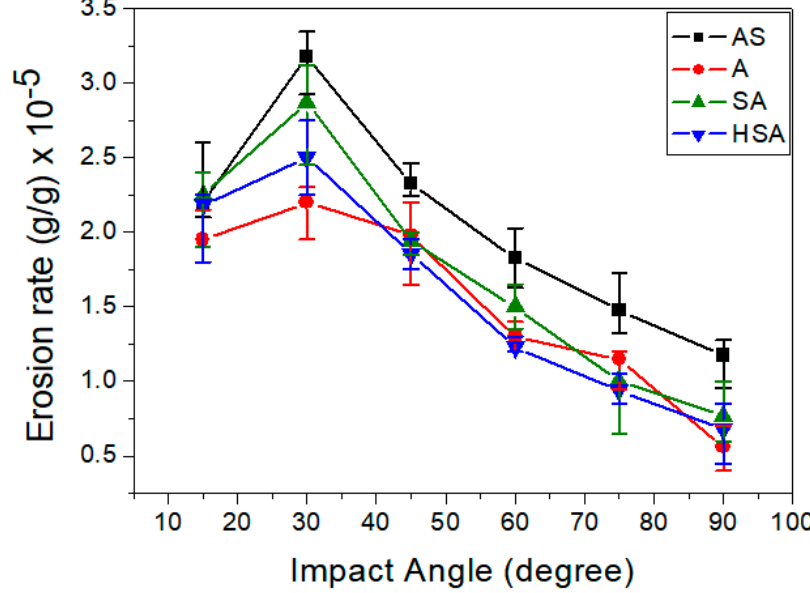
Figure 6. The erosion rates as a function of impact angle.